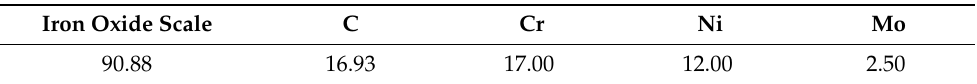
Table 4. Ingredient list of raw materials for porous 316 stainless steel, g.